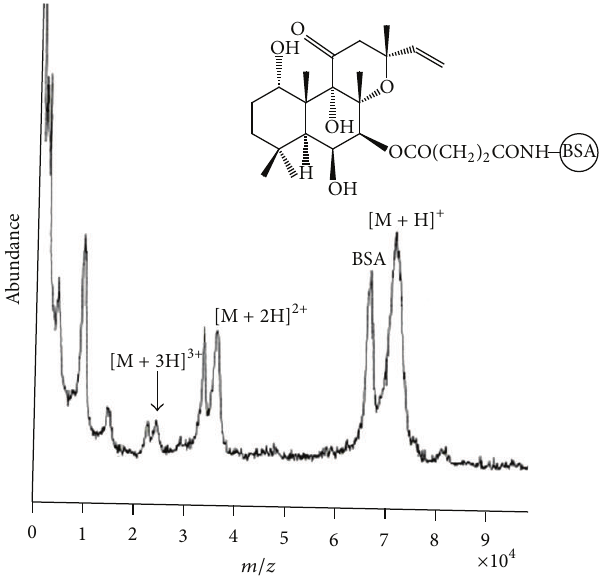
Figure 2: MALDI-TOF mass spectrum of forskolin-bovine serum albumin (BSA) conjugate and BSA as an internal